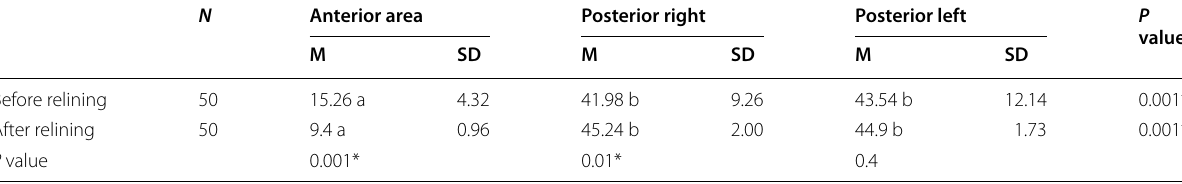
M mean, SD Standard deviation, N count, P Probability level, *Significantly different ( P <